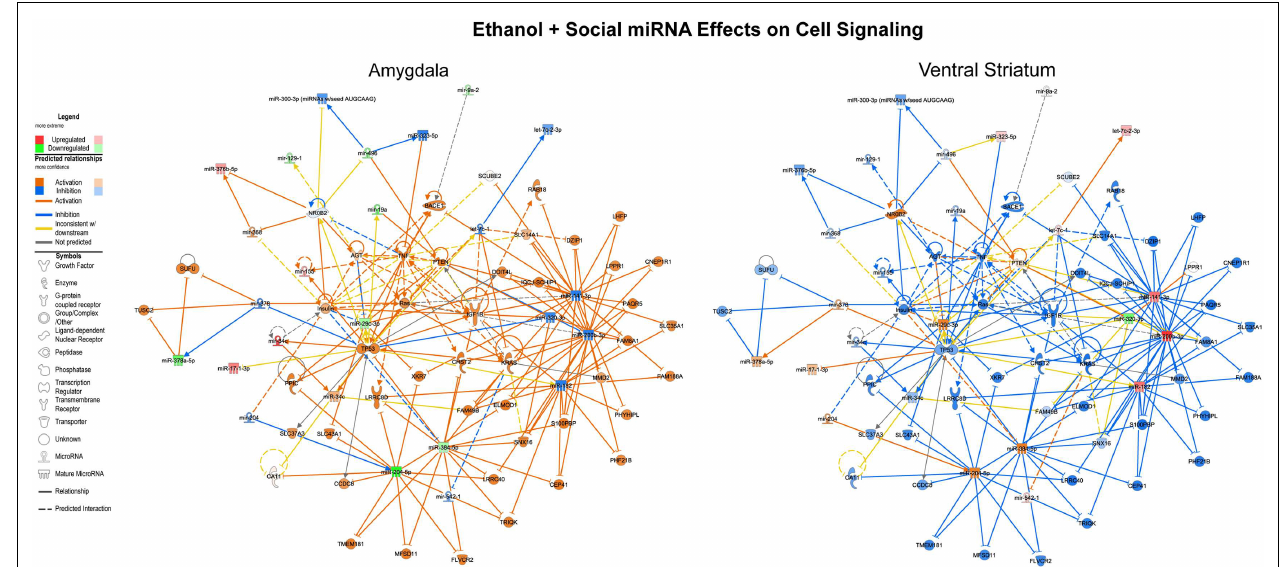
predicted decreased expression are shown in green and blue, respectively. Genes and miRNAs with conflicting predicted vs observed data are connected by yellow lines, and genes and miRNAs with absent data or unpredicted relationships are unfilled and connected by gray lines. Note that in general, the network is activated in the amygdala and inhibited in the ventral striatum.